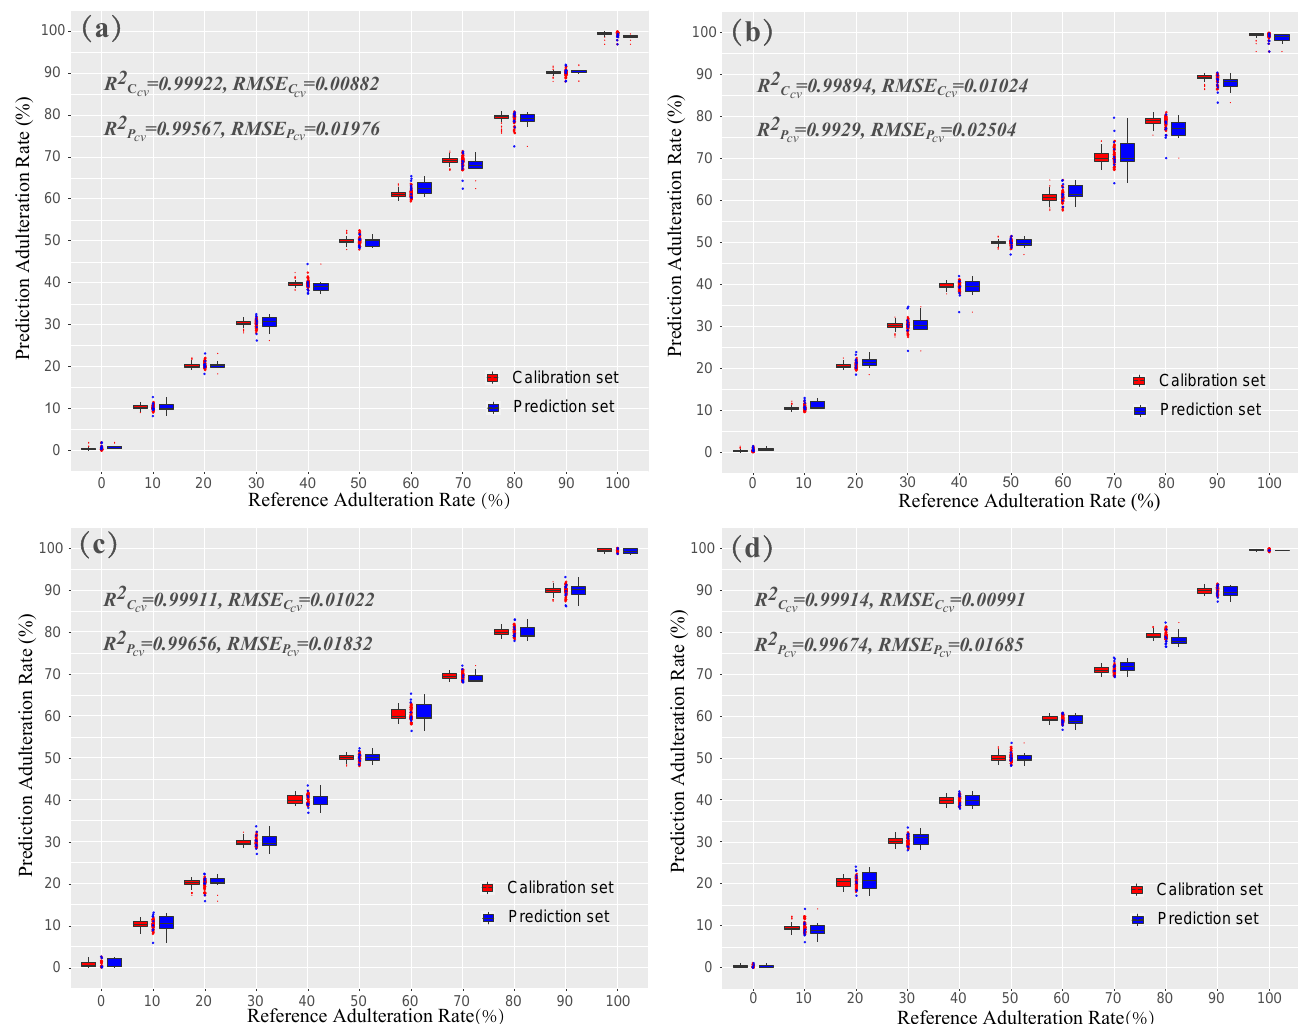
sides (red boxplots and blue boxplots) of each adulteration rate indicated the statistical characteristics of the prediction results. The horizontal lines at the bottom and roof of the boxplots represented the values of lower quartile and upper quartile of the data distribu- tion, respectively. The horizontal lines in the middle of the boxplots were the median value of the data distribution. There were some data points beyond the overall boxplot being regarded as the outliers in the experiments.